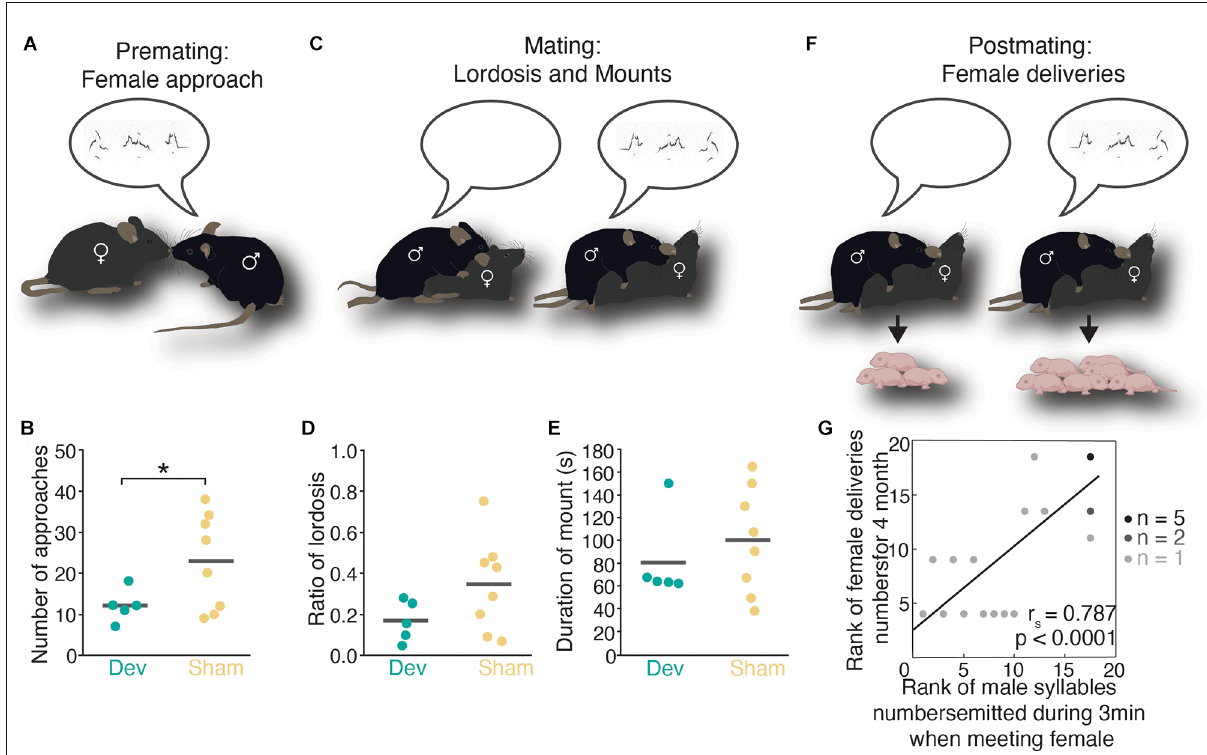
FIGURE1 Male mouse ultrasonic vocalizations and its impact on female mate choice during premating, mating, and postmating. (A) Male USV calls emitted during premating elicit female approach behavior. (B) Number of female approaches is significantly higher when the male sings compared to devocalized males. (C) Male USVs emission during mating leads to an increase in lordosis behavior. (D) Ratio of lordosis is higher in females than received mounts and intromission from males that emitted USVs compared to males that were devocalized. (E) The duration of mounts in devocalized or intact males is not different. (F) Female mice deliver more pups when mated with males that emitted USVs. (G) A significant correlation between the number of male USVs and female deliveries has been found. Panels (B,D,E,G) adapted and reprinted with permission from Asaba et al. (2017). *indicates significant differences ( p < 0.05) between devocalized male and sham-operated (Student’s